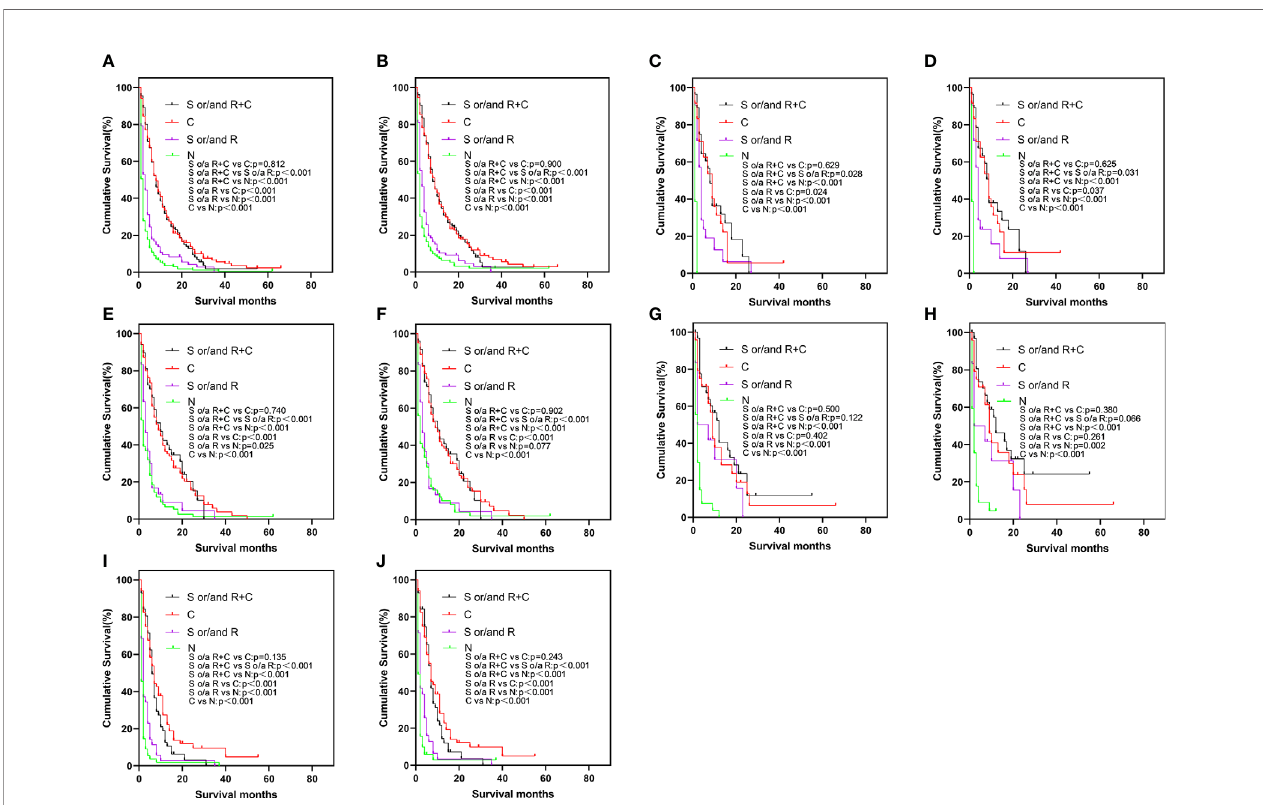
FIGURE 2 | Kaplan-Meier curve of OS (A) and CSS (B) by different treatments in the total study population, OS (C) and CSS (D) in bone-only group, OS (E) and CSS (F) in liver-only group, OS (G) and CSS (H) in lung-only group, OS (I) and CSS (J) in the multiple-site group. OS, overall survival; CSS, cancer-speci fi c